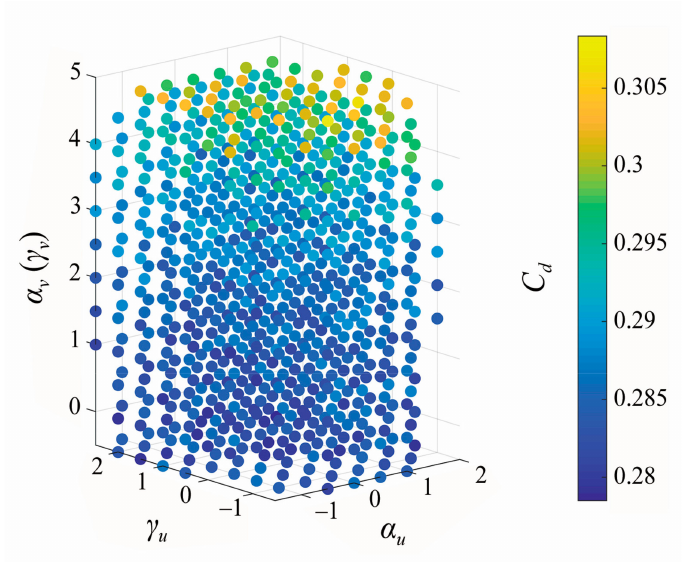
Figure 16. The e ff ect of α u , γ u ∈ 1 ± 5 and α v ( γ u ) ∈ [ − 0.5, 5] on C d .